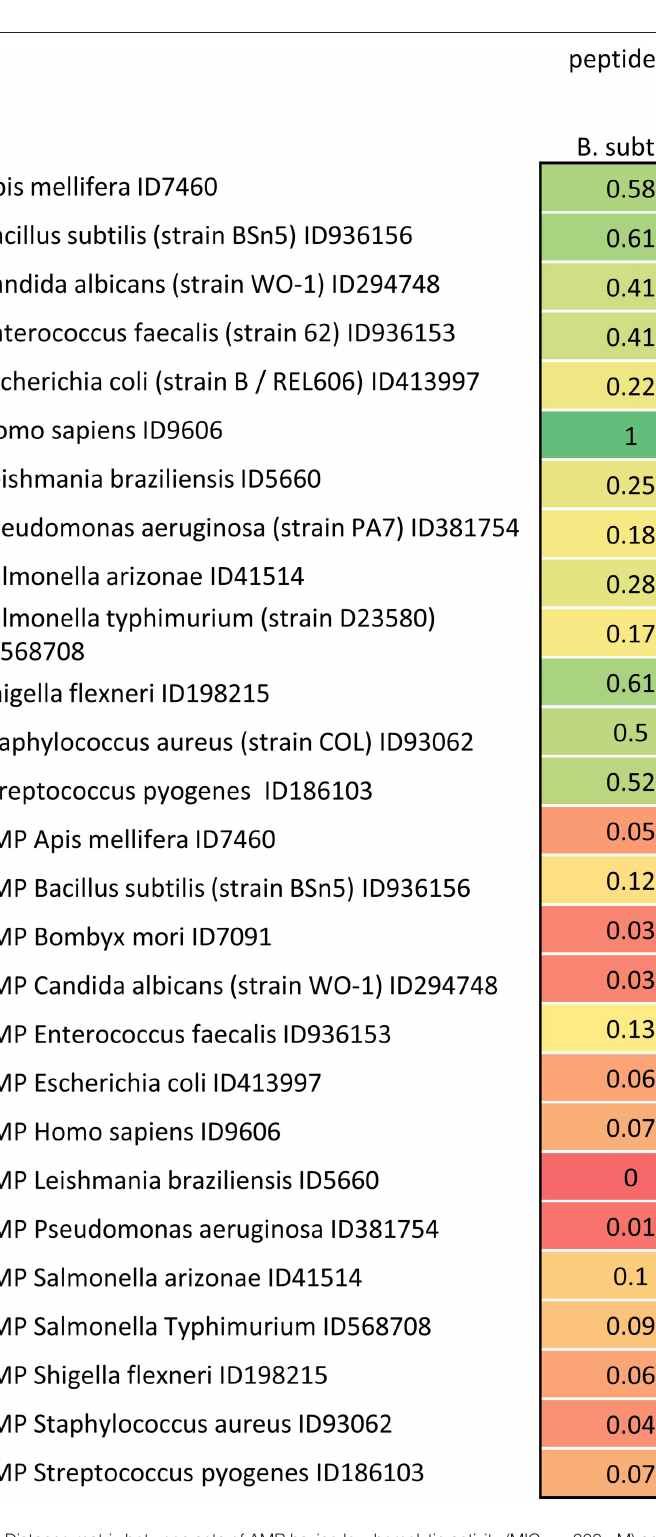
Frontiers in Physics | www.frontiersin.org